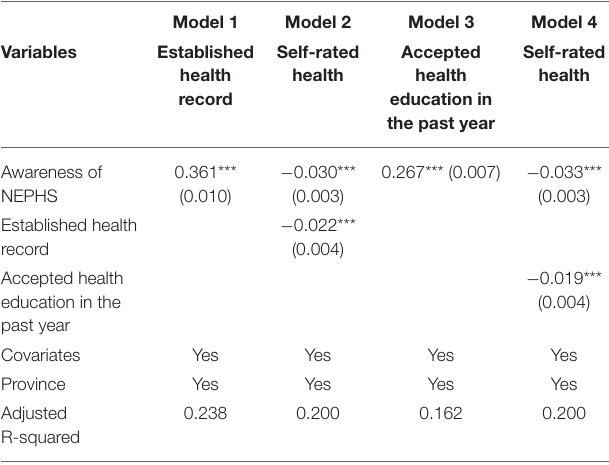
TABLE 6 | The results of mediating effect